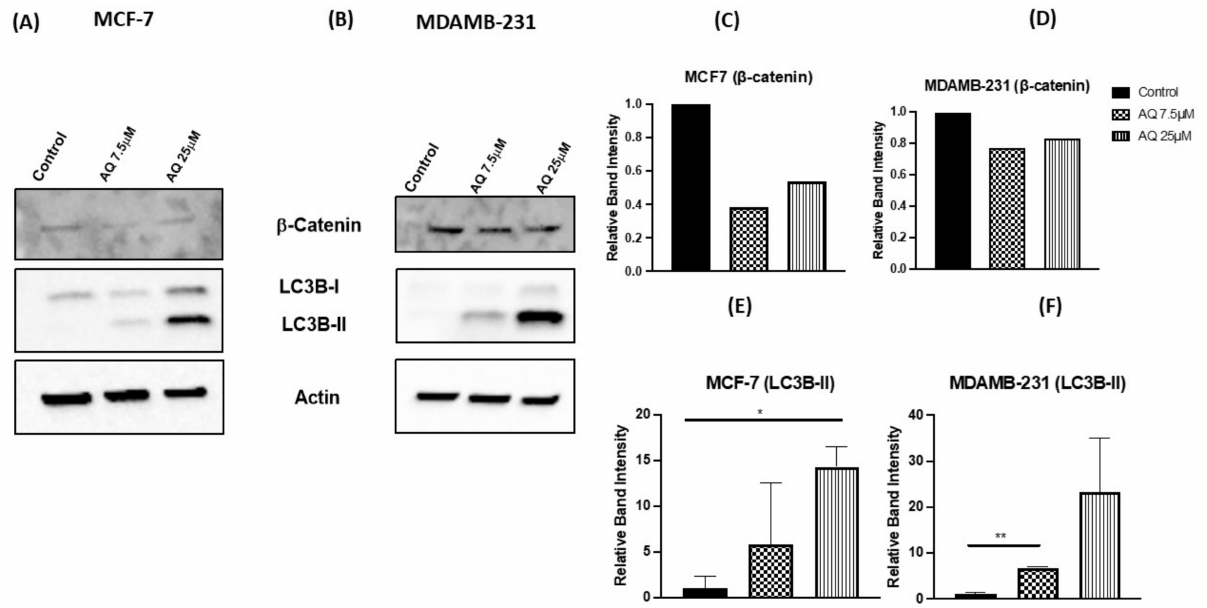
Figure 9. Western blots representing inducing effect of treatments on expression of β -catenin, and LC3BII proteins in MCF-7 ( A ) and MDAMB-231( B ) cells. (Number of experimental trials: LC3B-II: n = 2; β -catenin: n = 1). ( C , D ) Western blot representing expression level of β -catenin in MCF-7 and MDAMB-231 cell lines, respectively. ( E , F ) Western blot representing expression level of LC3B-II in MCF-7 and MDAMB-231 cell lines, respectively. * p < 0.05, ** p < 0.01.